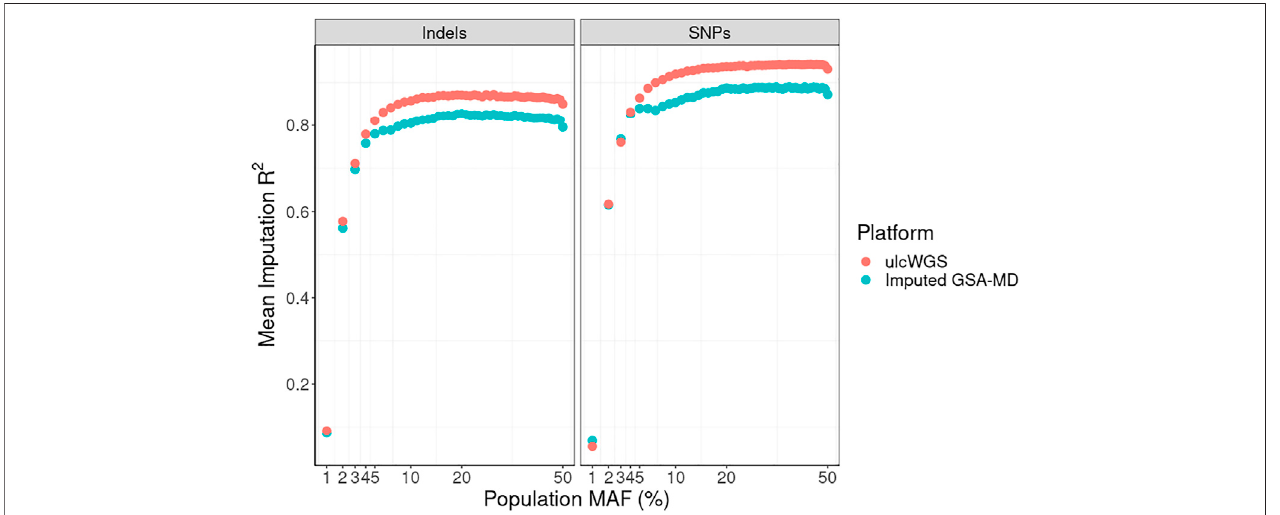
FIGURE 3 | Imputation R 2 score by population minor allele frequency. Mean imputation R 2 values were calculated separately for indels and SNPs and strati fi ed by population minor allele frequency (European gnomAD v2.0). All variants were un fi ltered.